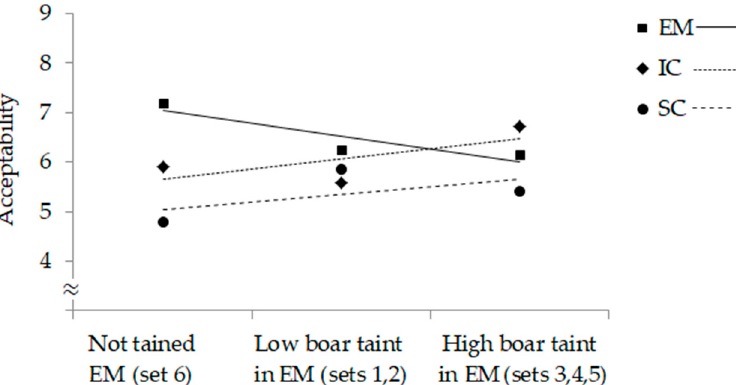
Figure 1. Change of consumer acceptability of pancetta according to the level of boar taint in EM. EM = entire males, IC = immunocastrates and SC = surgical castrates.